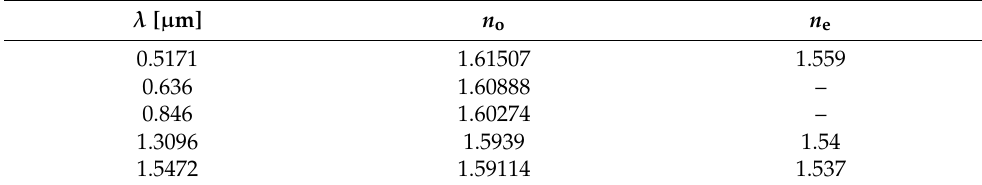
Table 1. The measured refractive index of the samples.